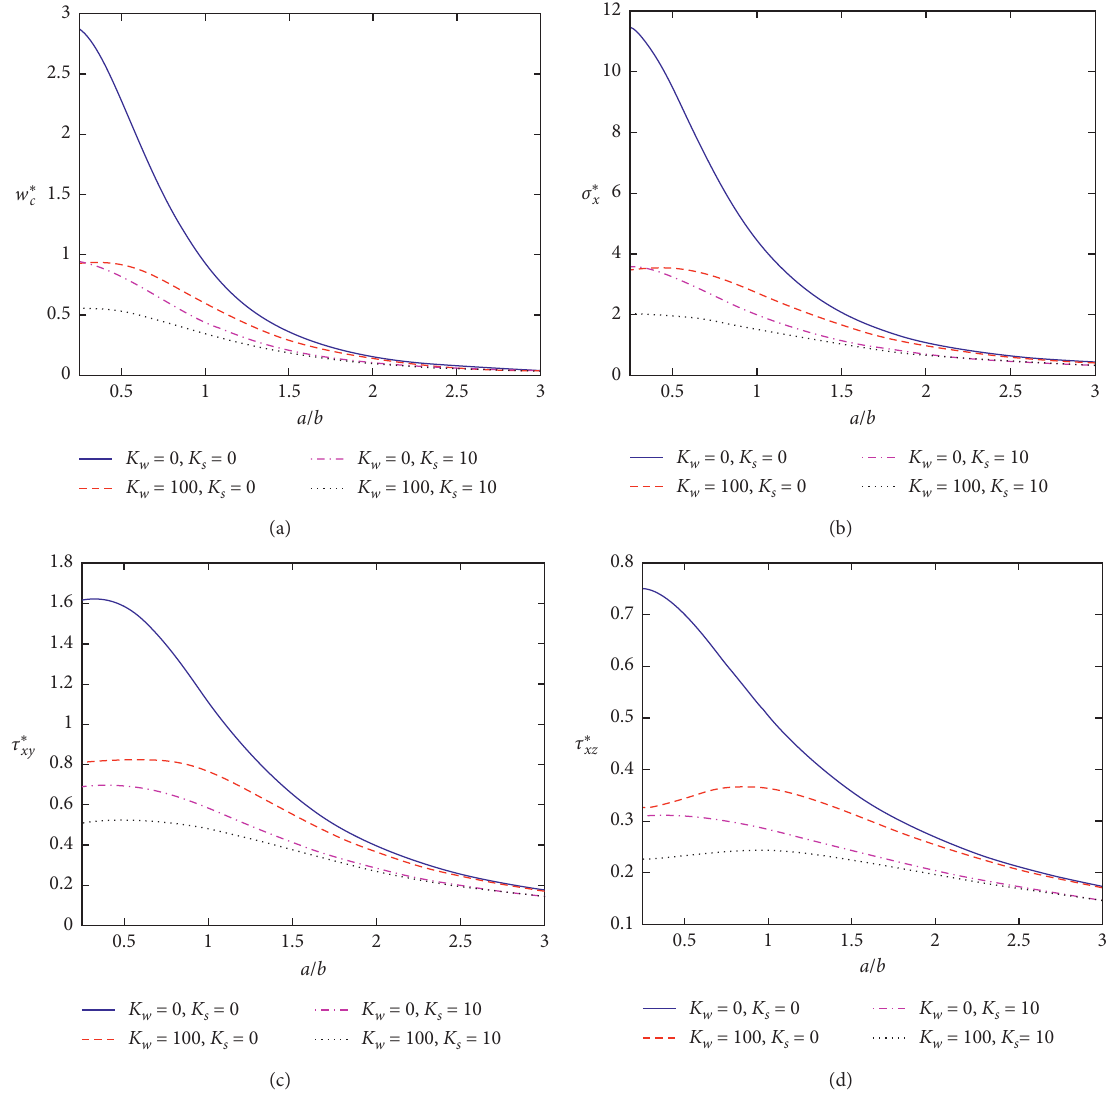
Figure 7: The variation of the deflection and stresses as the functions of aspect